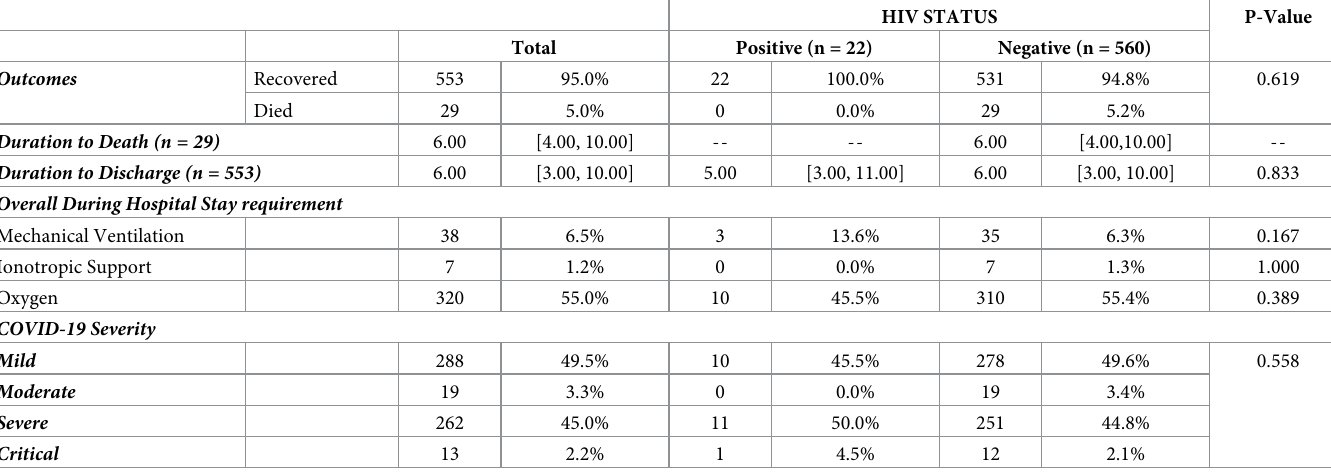
Table 3. Length of stay, disease severity and